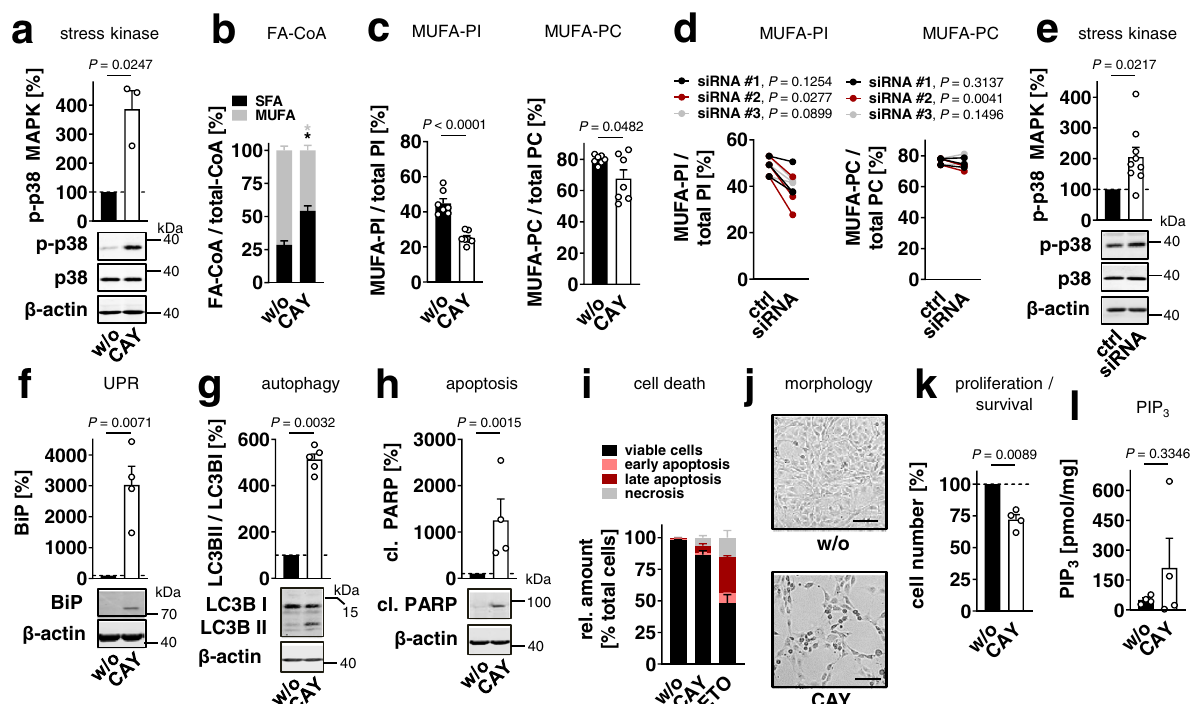
Fig. 4 SCD1 inhibition lowers MUFA-PI levels and induces stress signaling. Fibroblasts were treated with CAY10566 (CAY, 3 µ M) ( a – c , f – l ), ETO (10 µ M) ( i ) or Scd1 siRNA ( d , e ) for 48h. a , e Phosphorylation of p38 MAPK. Western blots are representative of three independent experiments. Data for e is identical to Fig. 6h. b Cellular proportion of SFA-CoAs and MUFA-CoAs. SFA: 16:0-CoA; MUFAs: 16:1-CoA, 18:1-CoA (SFA P = 0.0168, MUFA P = 0.0168). c , d Cellular proportion ofPI- and PC-bound MUFAs ( P = 0.0000099). d Non-targeting siRNA wastransfected ascontrol(ctrl).Interconnectedlinesindicate